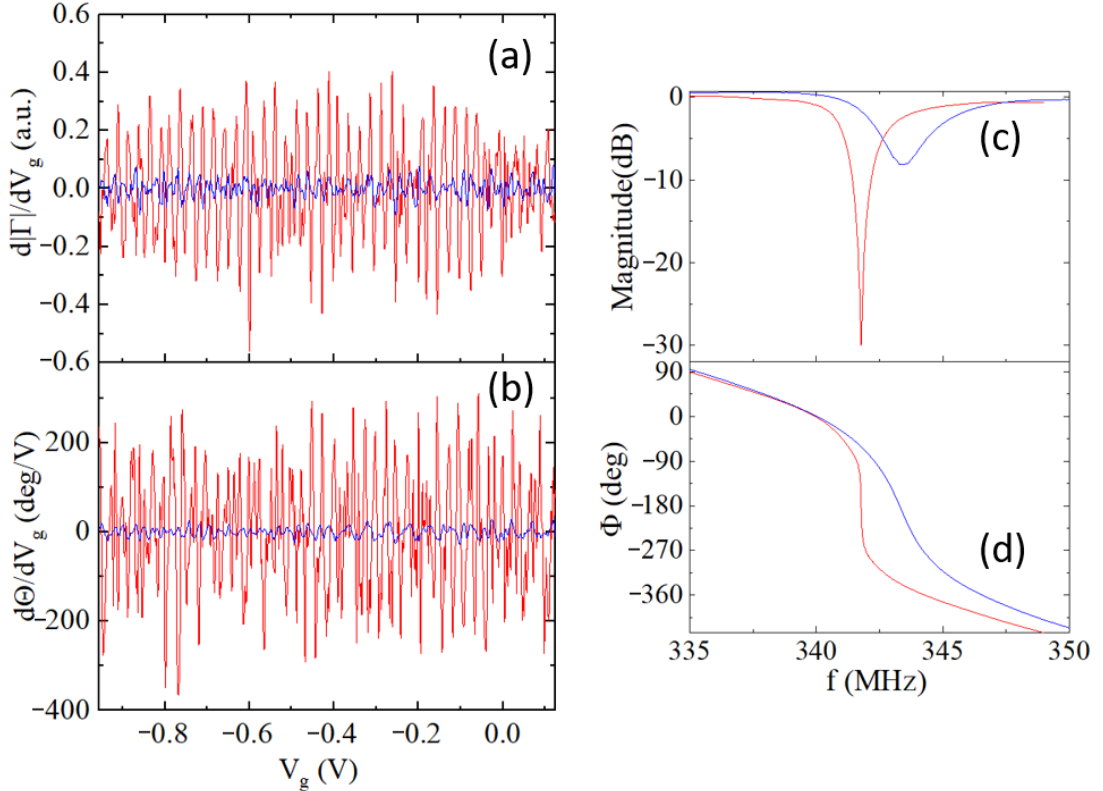
Figure 14. Comparison between the response of the same array of 200 SEB at T = 4.5 K with two different settings of the Π -network (Figure 4a) is composed of L = 270 nH Coilcrtaft 0805CS inductor, C pad = 0.55 pF and C IN : red— C IN = 27 pF, blue— C IN = 18 pF. ( a ) Comparison of derivatives d | Γ |/ dV g ; ( b ) Comparison of derivatives d Θ / dV g . Comparison of the magnitude ( c ) and phase ( d ) characteristics of the two MNs.